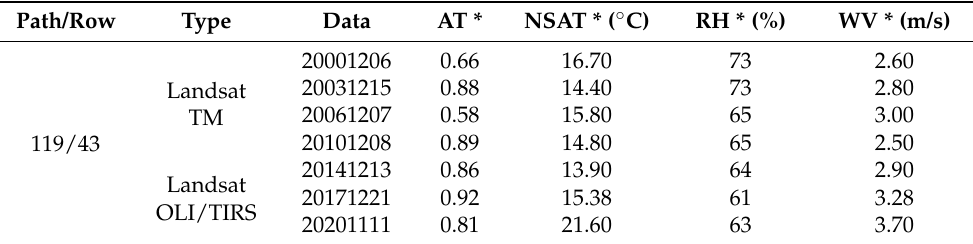
Table A1. The image information of Landsat series data and weather parameters of these scenes.